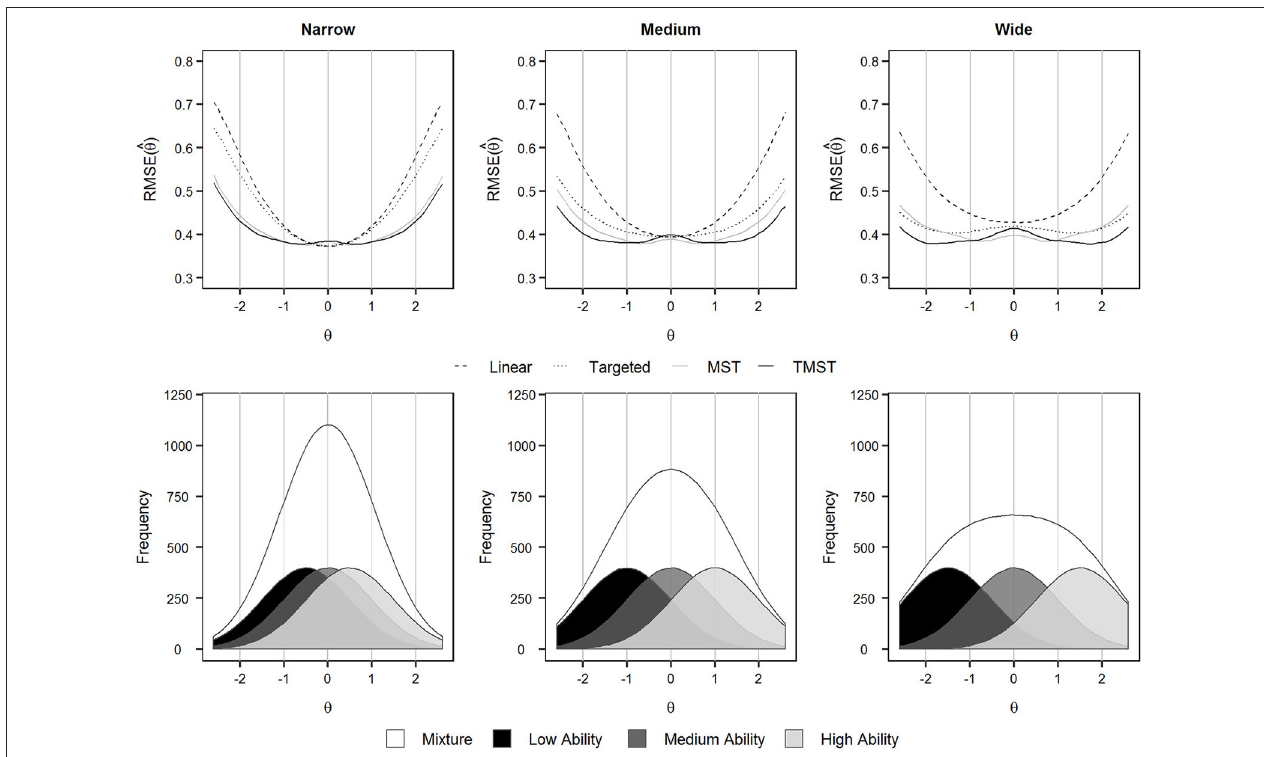
FIGURE 2 | RMSE( ˆ θ ) in relation to ability for the different designs under the three distribution conditions and related frequency distributions of the ability groups. the modules differ more, and the consequences of possible misallocations